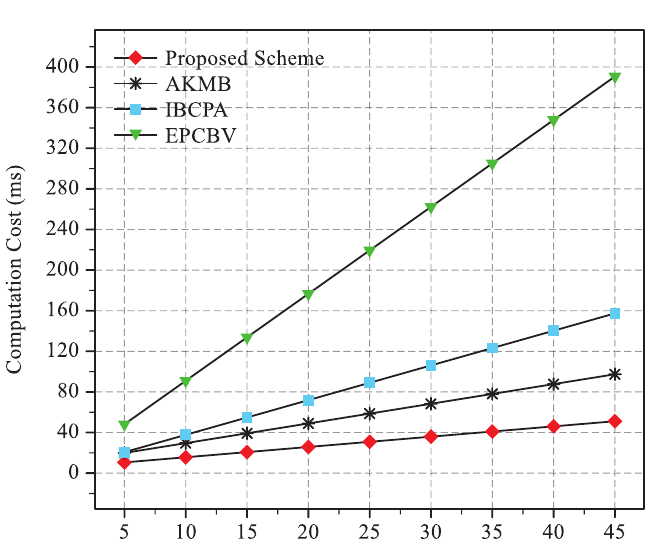
Figure 4. Comparison Results of Computation